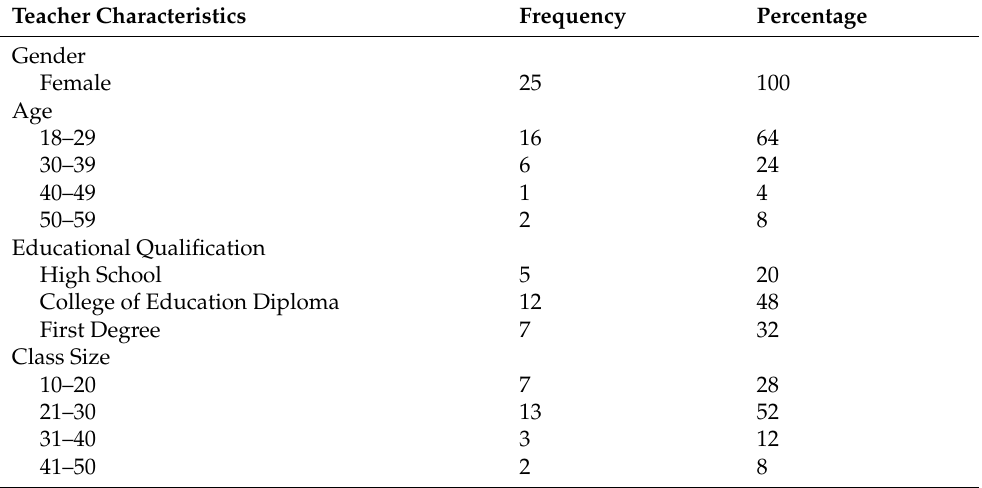
Table 1. Demographic characteristics of the